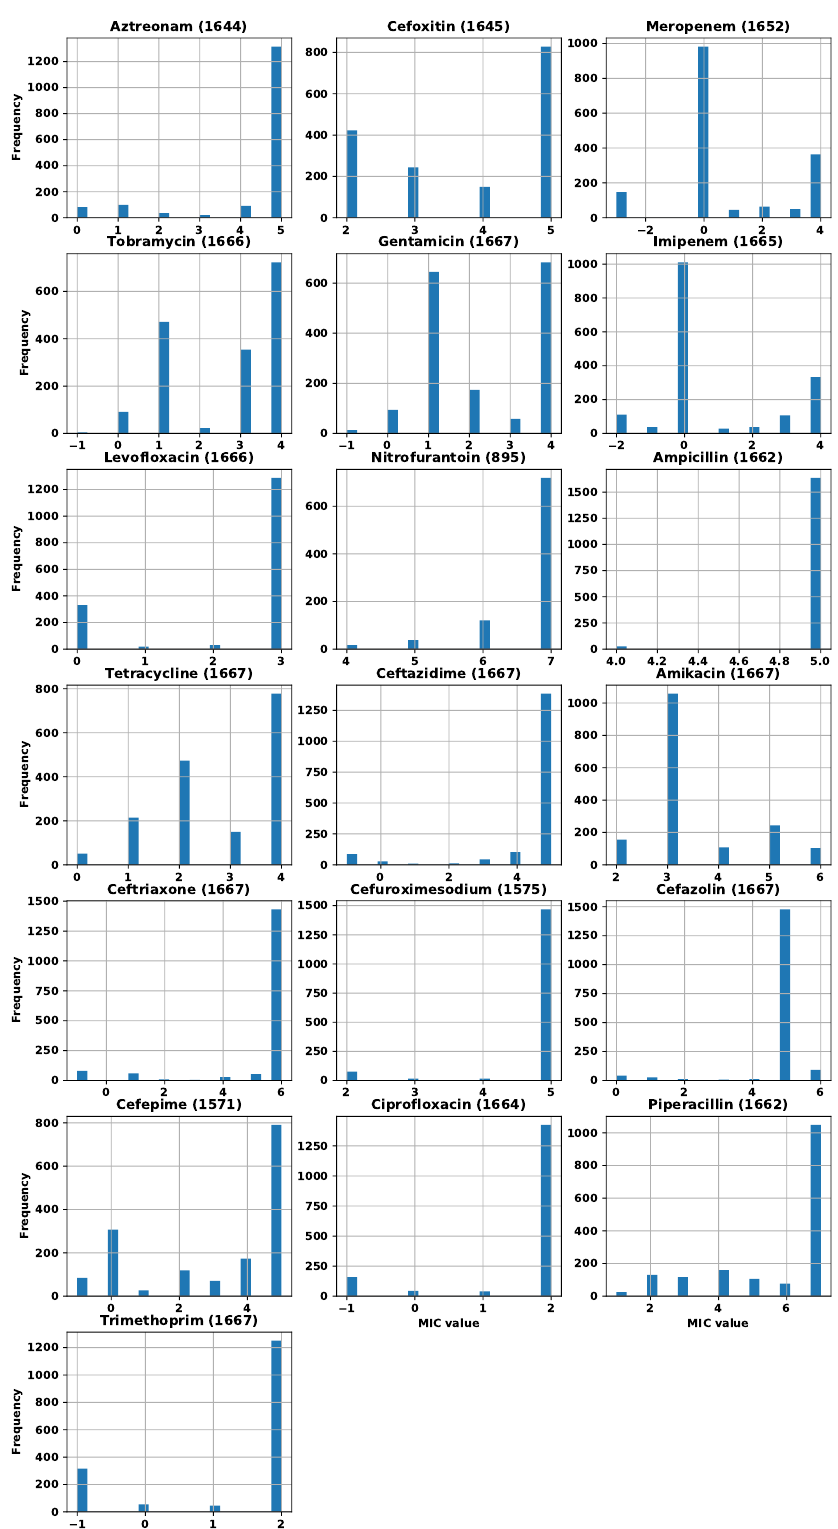
Figure A3. Distribution of K. pneumoniae MIC values for different antibiotics. These are the values after processing and conversion to log 2 scale. The antibiotic’s name is printed on the title of each sub-figure. The number of genomes is presented in